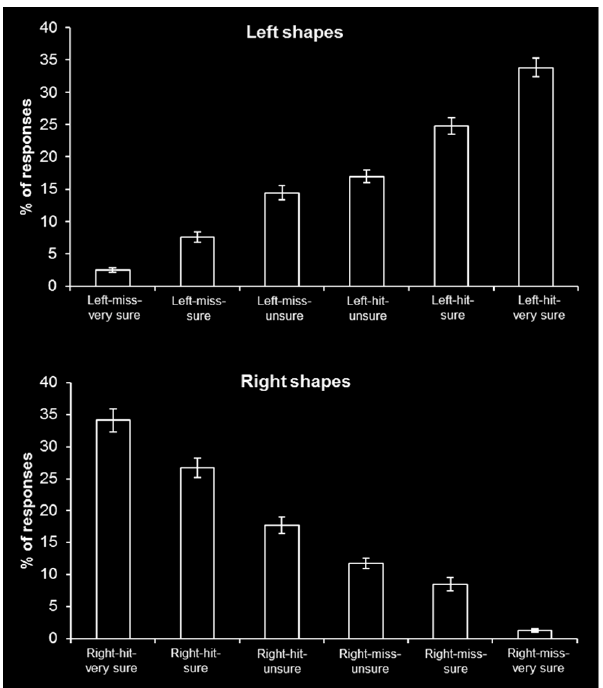
Figure 3. Behavioral response distributions. Percentage of responses for each left shape and right shape event type (mean ± S.E.).